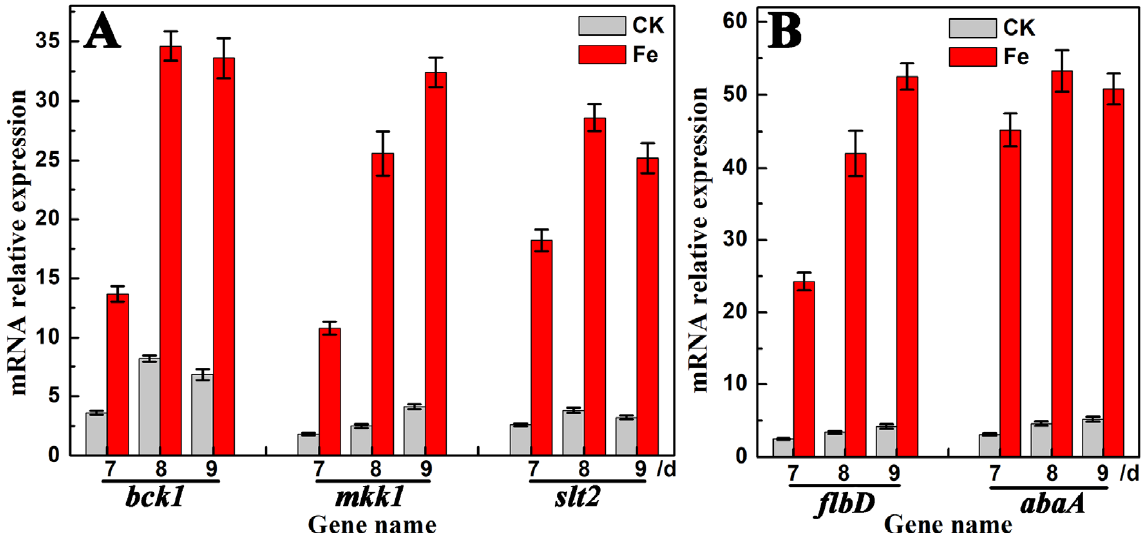
Figure 4. Expression levels of genes involve in CWI pathway ( A ) and FluG ‐ mediated patthway ( B ) in the mycelium samples of A. cinnamomea . Note: “mRNA”, messenger RNA; “CK”, the mycelia cultured absence of Fe 2+ ; “Fe”, the mycelia cultured in the presence of 0.1 mmol/L of Fe 2+ . The 18S rRNA gene of A. cinnamomea was taken as the internal reference.